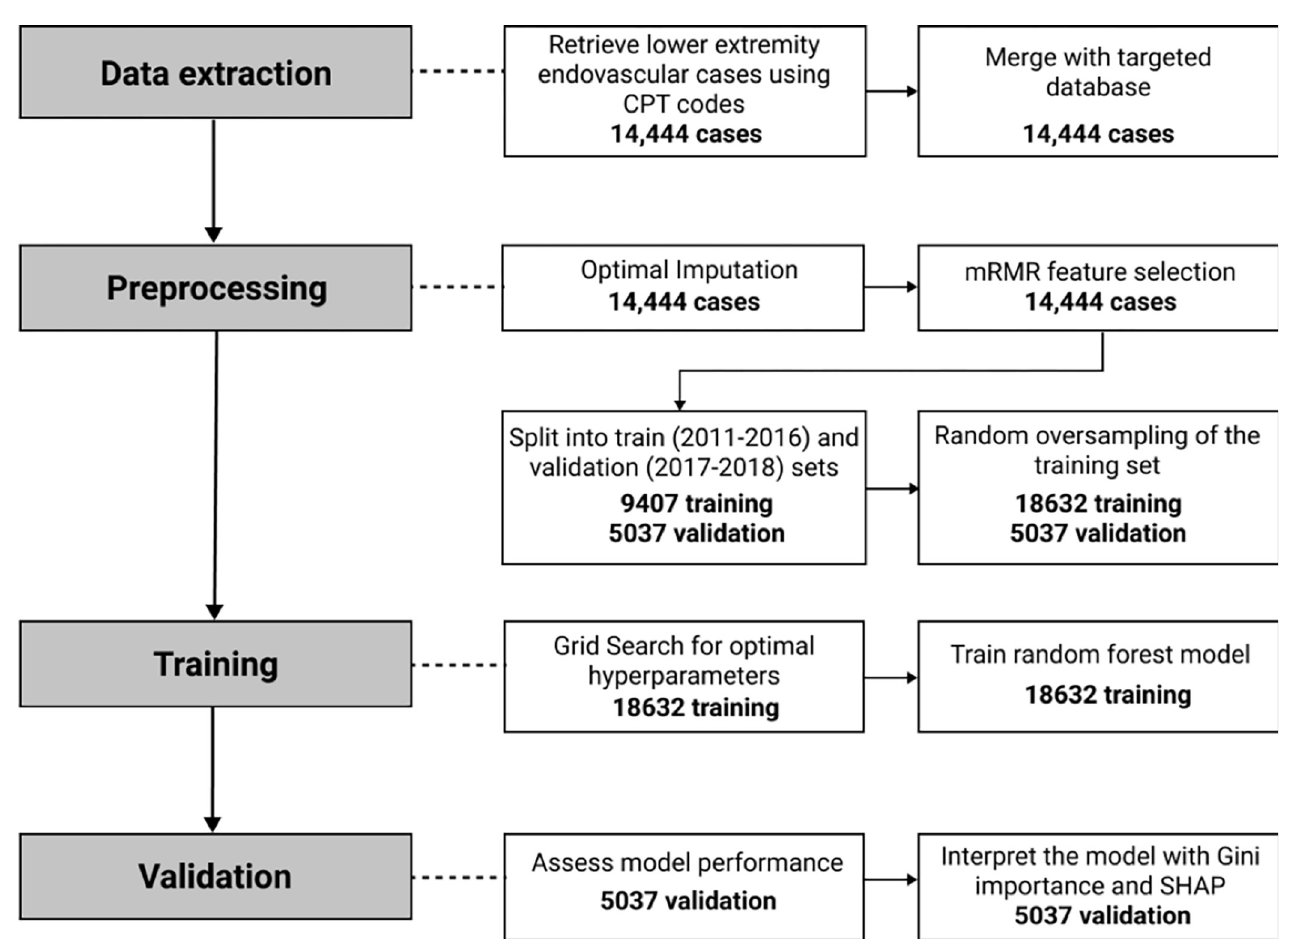
Fig 1. Flow chart illustrating the phases of model development. accuracy of 0.87 sensitivity of 0.77 and specificity of 0.68 on the test set. On the training set, the model achieved an AU-ROC of 0.89, accuracy of 0.88, sensitivity of 0.69, and specificity of crit, blood urea nitrogen (BUN), creatinine, claudication, albumin, age, elective surgery desig- nation, white blood cell count, serum glutamic oxaloacetic transaminase (SGOT), international normalized ratio (INR), alkaline phosphatase, bilirubin, platelet count, functional status, renal comorbidities, dyspnea, and open wound or wound infection.